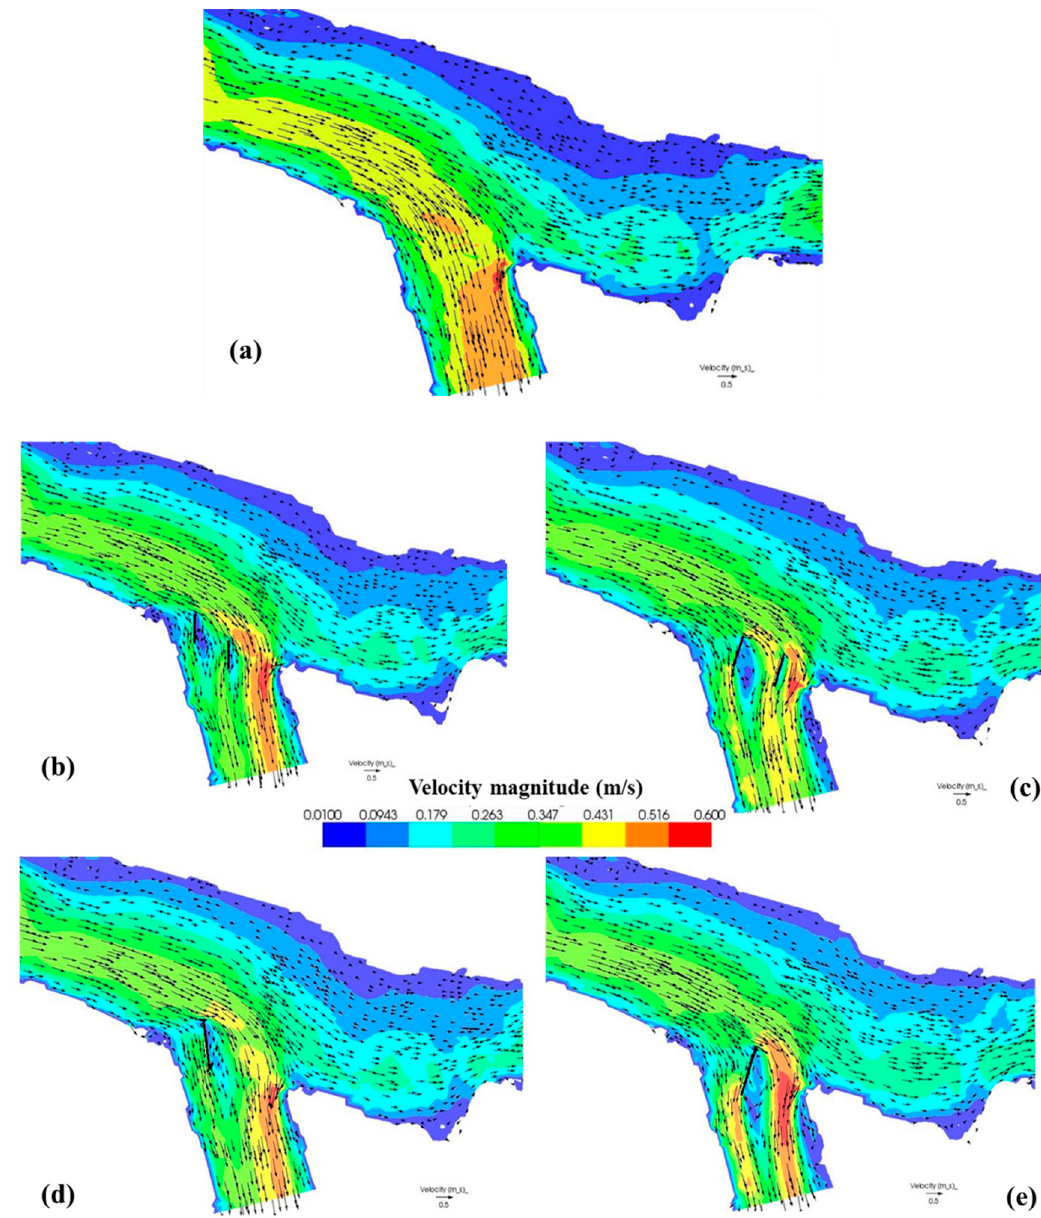
Figure 14. Simulated velocity distribution with its vectors for the study site ( a ) without vanes structure; ( b ) First configuration; ( c ) Second configuration; ( d ) Third configuration; ( e ) Fourth configuration.